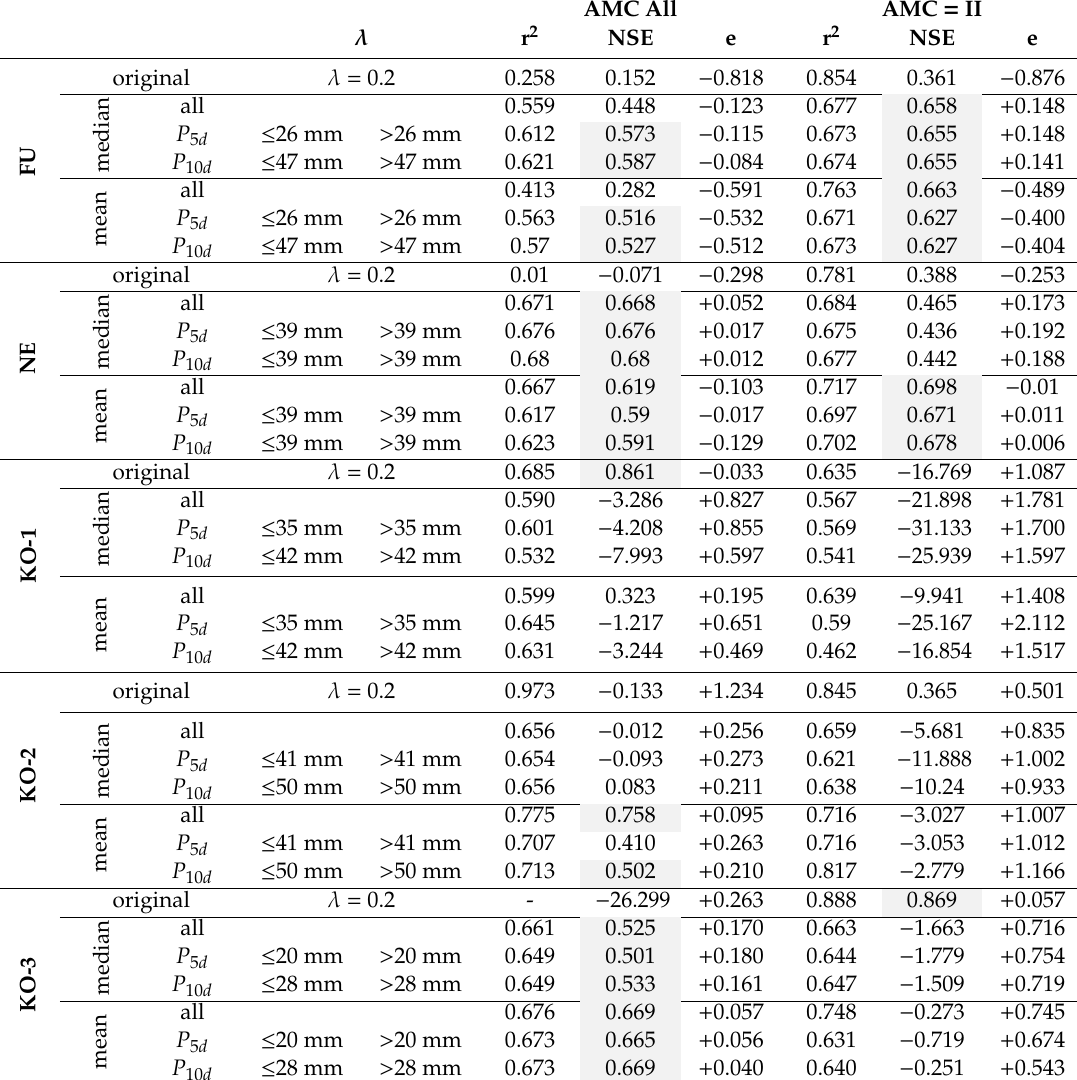
Table 6. Accuracy of direct runo ff simulations using mean and median λ values in the experimental catchments with (antecedent moisture condition (AMC) all) and without (AMC = II) determination of AMC classes. NSE ≥ 0.500 indicating su ffi cient accuracy are